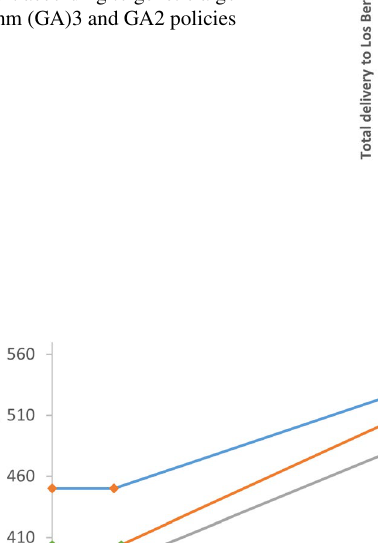
Fig. 21 The monthly quantity of water arriving to the Los Berros plant according to genetic algo‑ rithm (GA)3 and GA2 policies